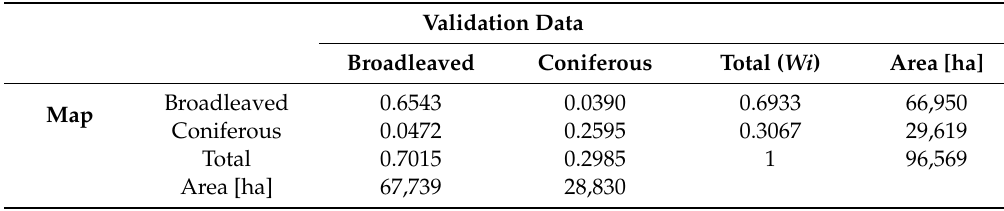
Table 9. Error matrix of estimated proportions of area (bootstrap based prediction map using Sentinel-2 derived NDVI in Luxembourg).